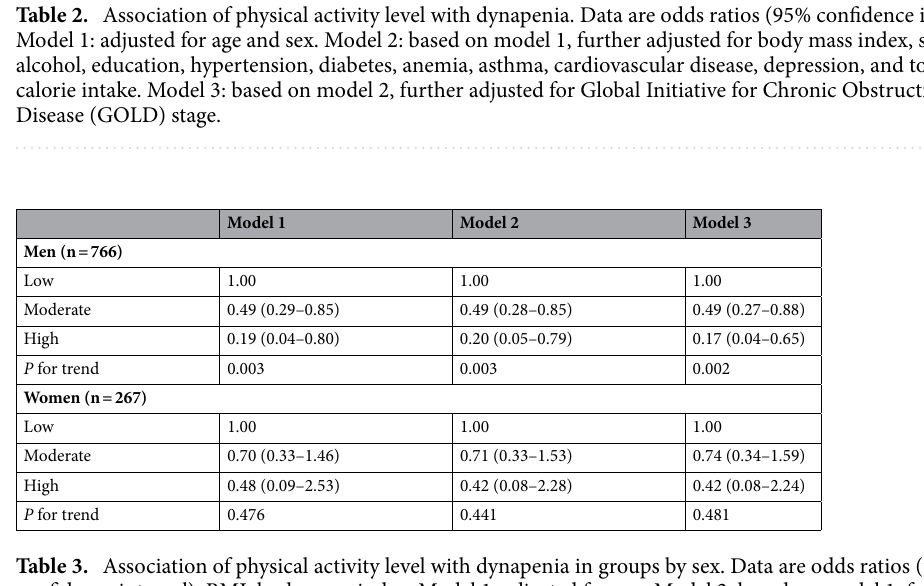
Table 3. Association of physical activity level with dynapenia in groups by sex. Data are odds ratios (95% confidence interval). BMI, body mass index. Model 1: adjusted for age. Model 2: based on model 1, further adjusted for BMI, smoking, alcohol, education, hypertension, diabetes, anemia, asthma, cardiovascular disease, depression, and total calorie intake. Model 3: based on model 2, further adjusted for Global Initiative for Chronic Obstructive Lung Disease (GOLD) stage.